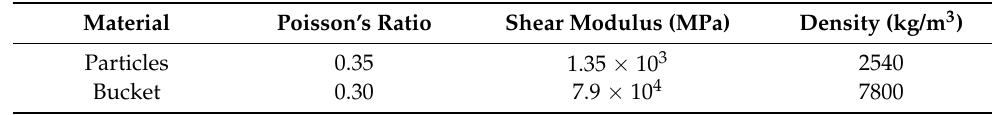
Table 2. Material properties of the pellets and bucket.